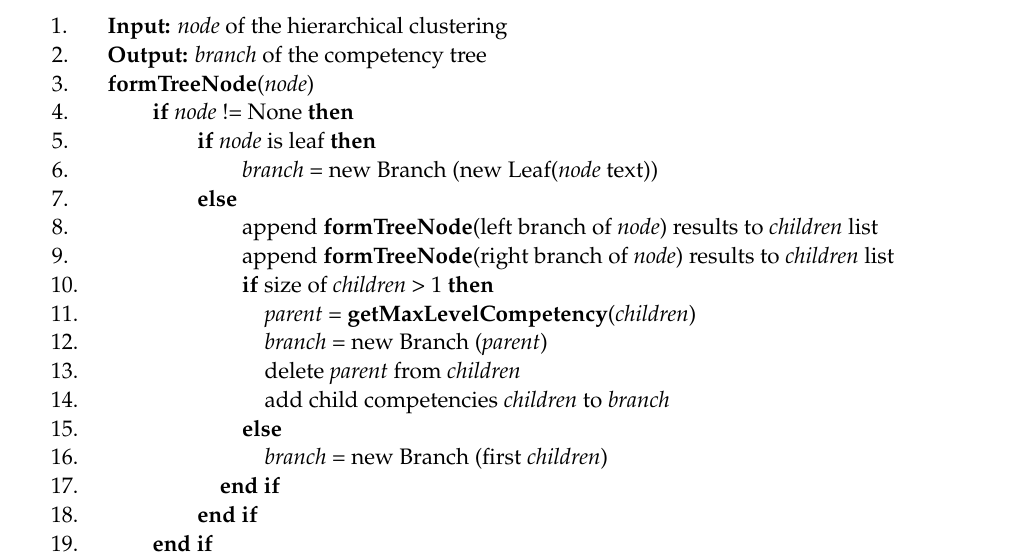
Algorithm 1. Pseudocode of tree formation from hierarchical